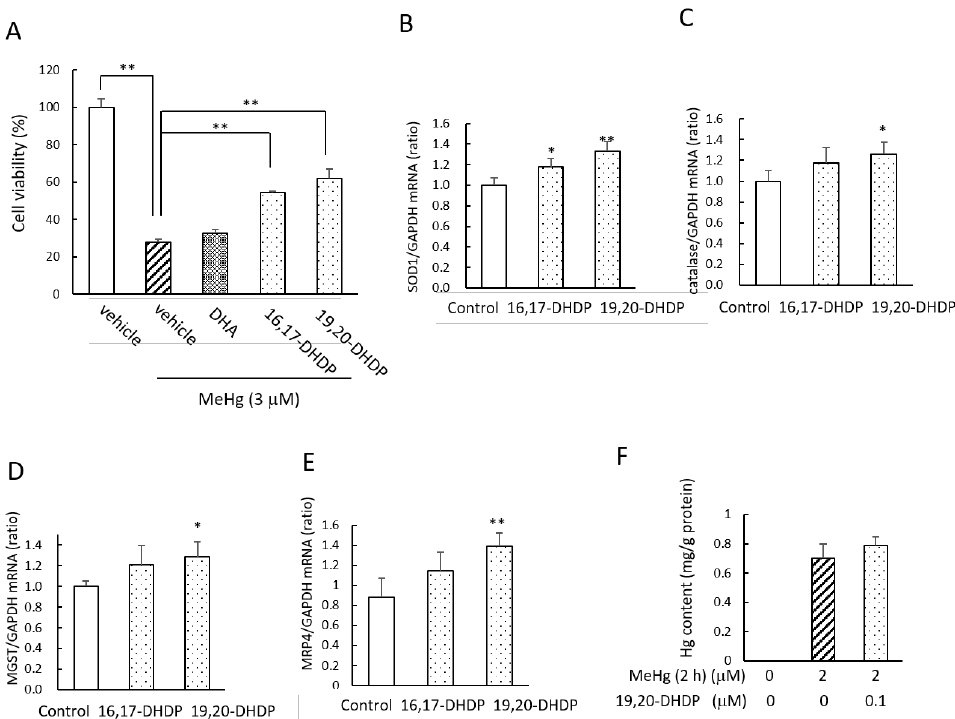
Figure 4. DHA metabolites DHDPs also have protective effects against MeHg-induced neurotoxicity. ( A ) Mouse primary neuronal cells were pretreated with DHA or a DHDP at the concentration of 0.1 µ M for 24 h. Then, 3 µ M MeHg was applied together with DHA or a DHDP to the cells for 24 h, and the cell viability was measured by MTT assay. ( B – E ) Mouse primary neuronal cells were treated with a DHDP at a concentration of 0.1 µ M for 6 h, and the mRNA levels of SOD1 , catalase , MGST , and MRP4 were measured by real-time PCR. ( F ) SH-SY5Y cells were pretreated with 0.1 µ M 19,20-DHDP for 24 h, and then 2 µ M MeHg was applied to the cells together with 19,20-DHDP for 2 h. After the cells were washed with PBS, the Hg content of the cells was determined using a direct thermal decomposition mercury analyzer. Values are the mean ± SD for 4–5 experiments. * p < 0.05; ** p < 0.01.